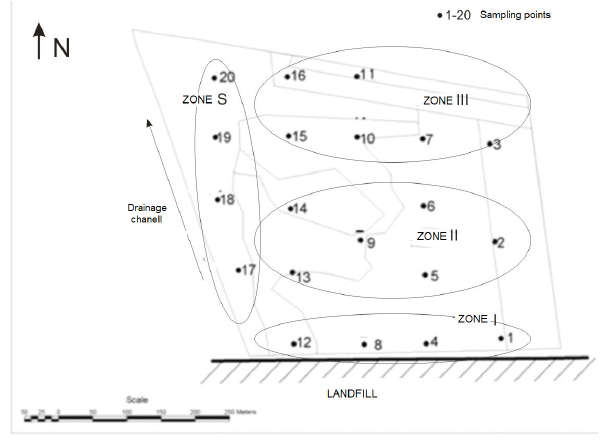
Figure 1: Location of sampling points in the study site adjacent to the tailing waste landfill